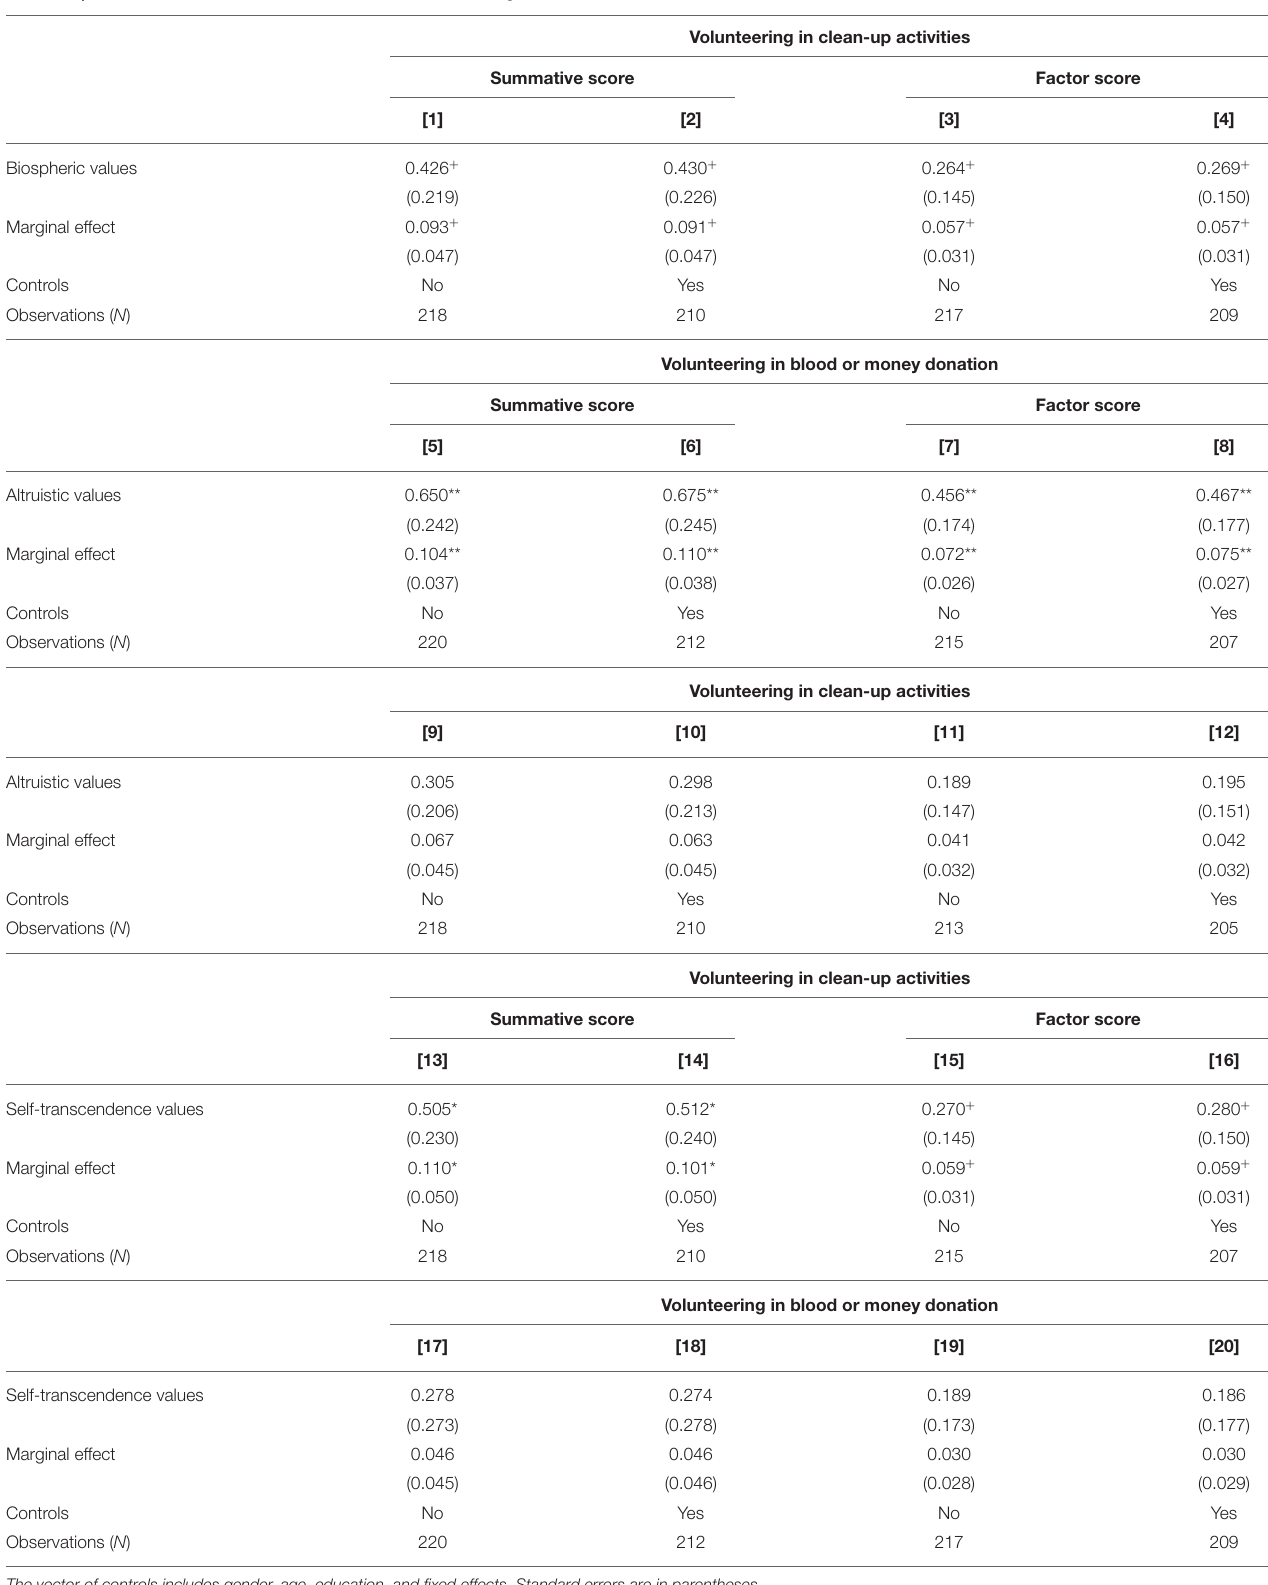
TABLE 2 | Effects of human values on different fields of